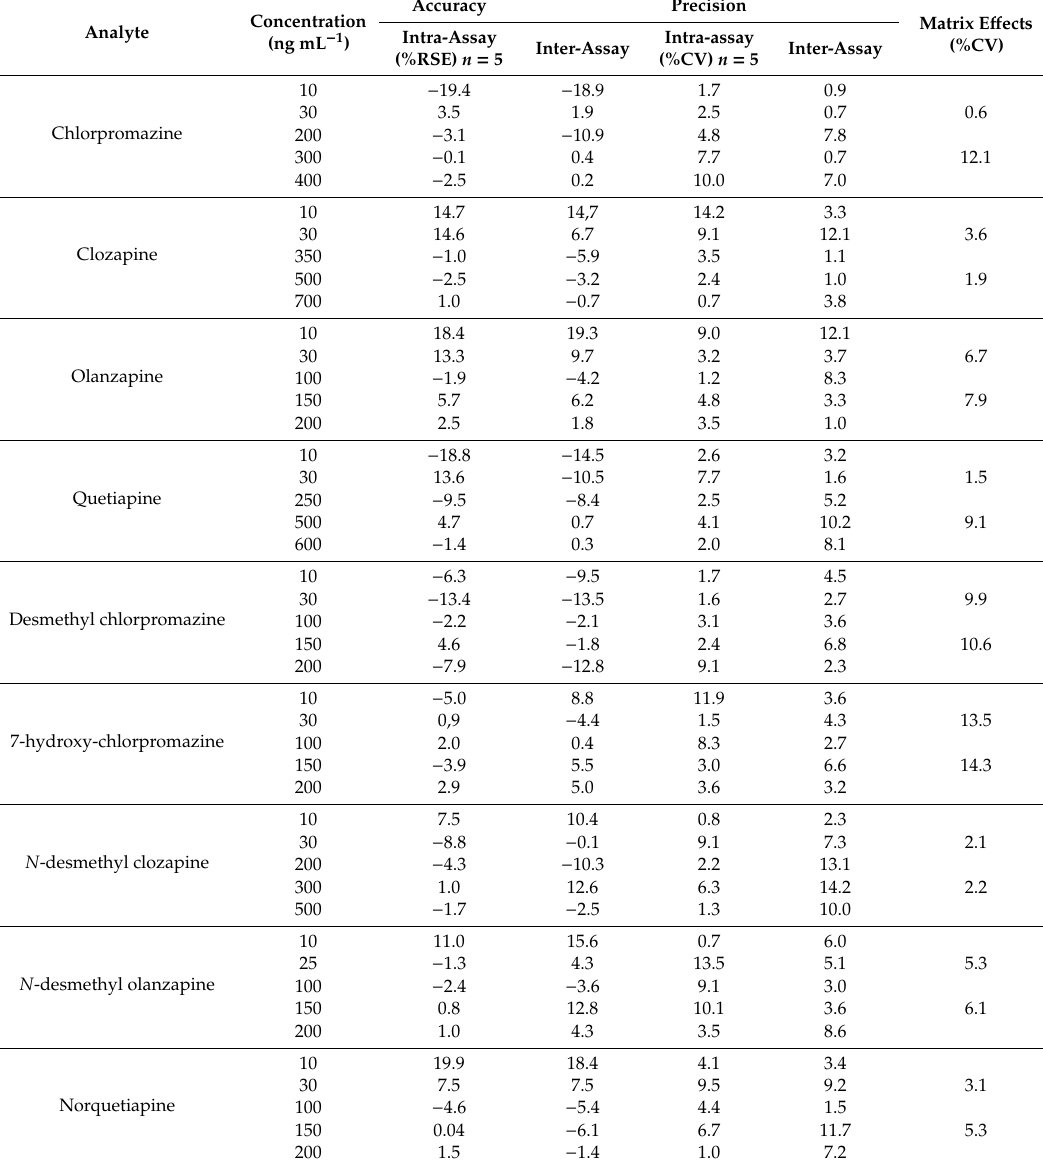
Table 4. Accuracy, precision, and matrix e ff ects of the SPME-UHPLC-MS / MS